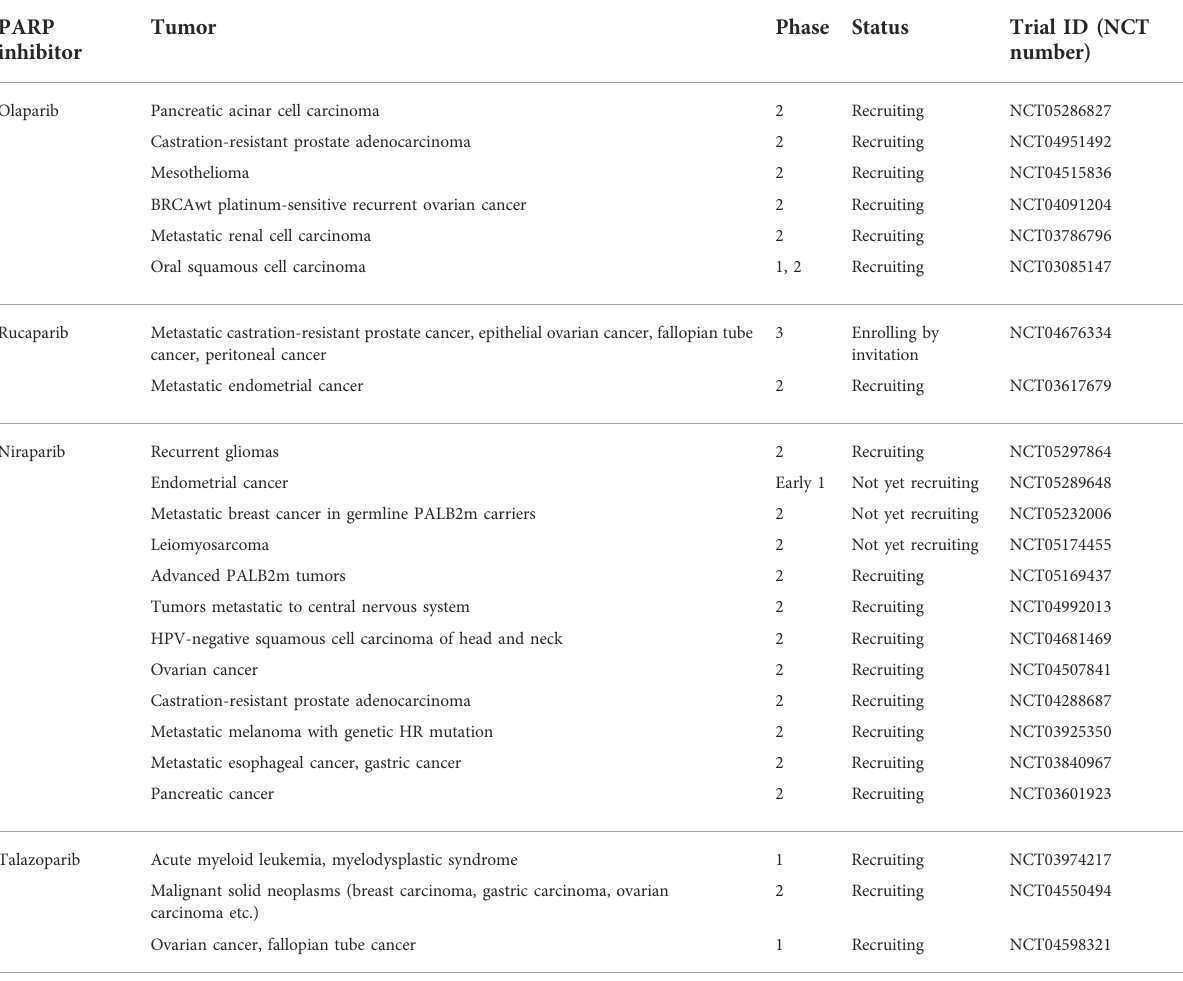
TABLE 2 List of selected PARP inhibitor monotherapy trials. Full access to the research studies description is available on ClinicalTrials.gov. PARP Tumor inhibitor Olaparib